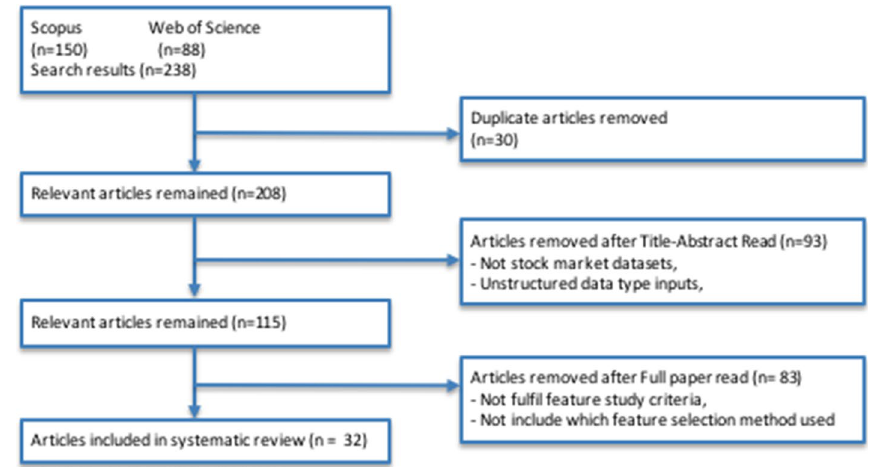
Fig. 2 Flow diagram of the selected